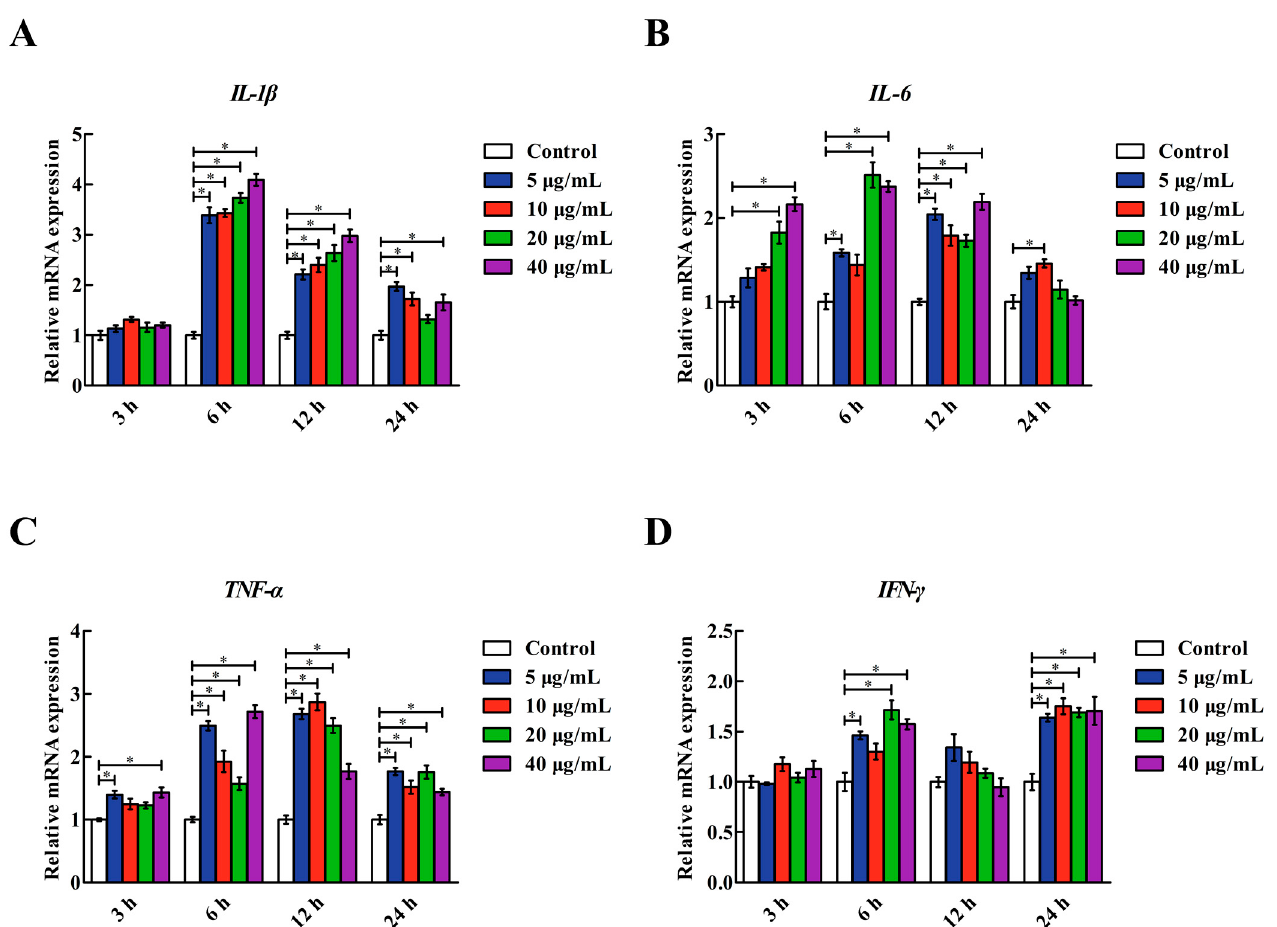
Figure 1. Effects of various LPS concentrations and reaction times on the IL-1 β , IL-6 , TNF- α and IFN- γ mRNA levels in IPEC-J2 cells. ( A ) IL-1 β : interleukin-1 β . ( B ) IL-6 : interleukin-6. ( C ) TNF- α : tumour necrosis factor- α . ( D ) IFN- γ : interferon- γ . Cells were treated with various concentrations of LPS (0, 5, 10, 20 and 40 µ g/mL) for 3, 6, 12 and 24 h. Data are presented as the mean ± standard error ( n = 4). * Means significant difference compared with the control group ( p < 0.05).